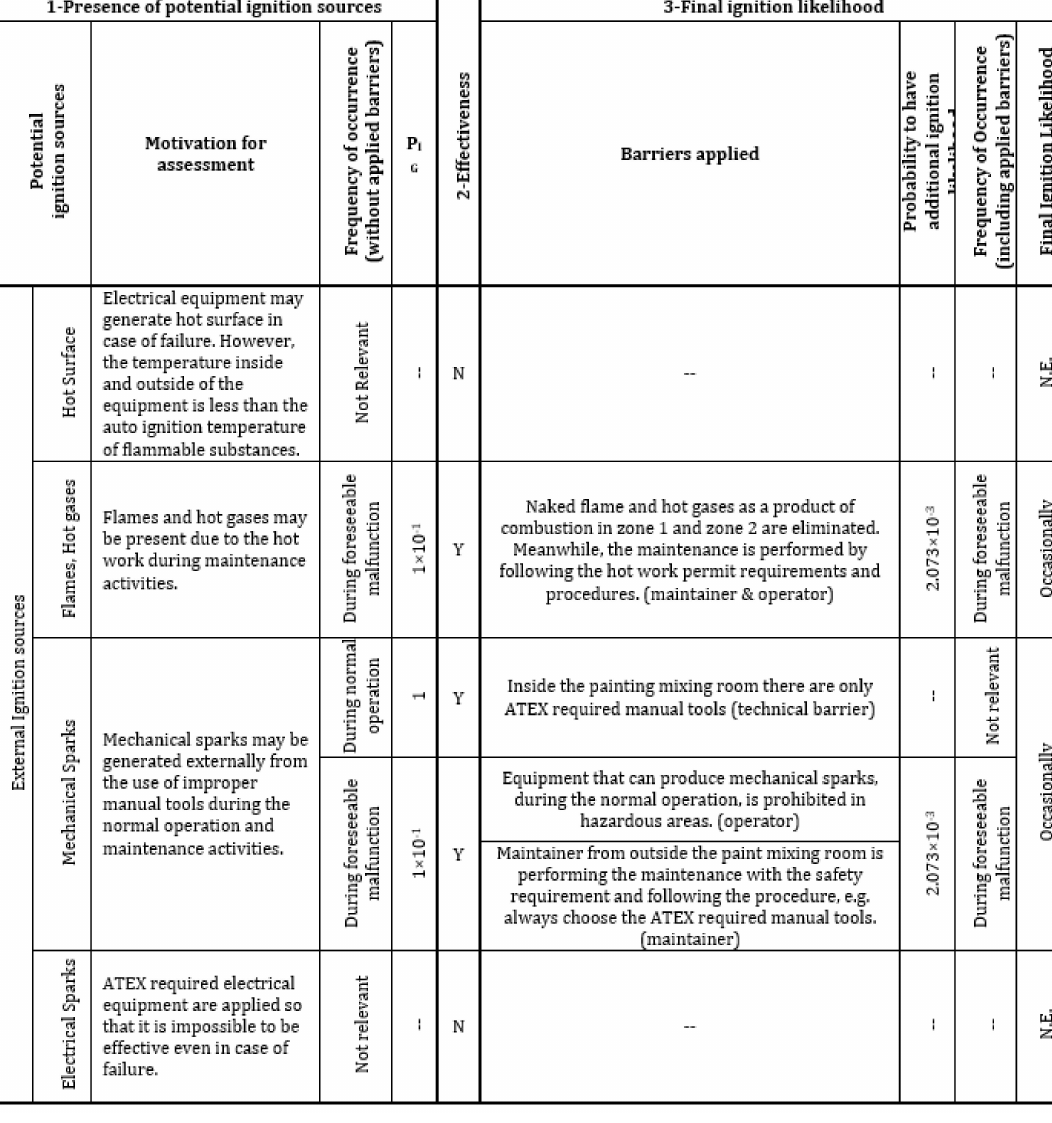
Figure A2. External ignition sources estimation within the ATEX-HOF methodology (part